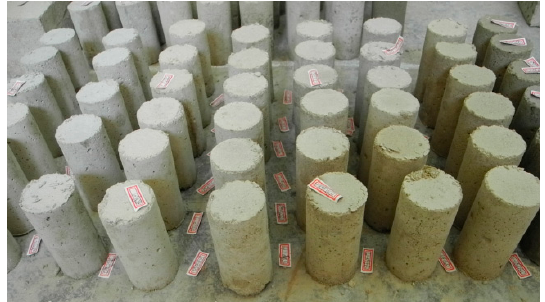
Figure 2. Sample of similar material.